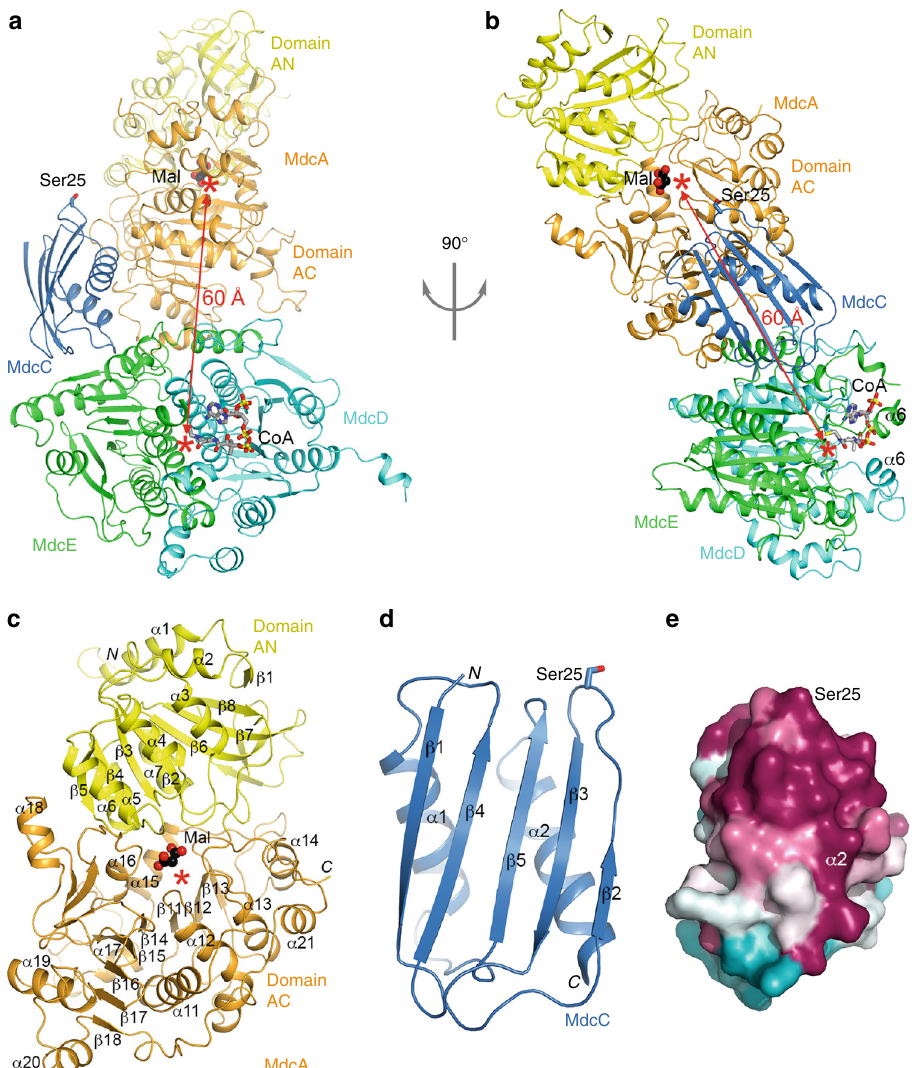
Figure 3 Structure of the MDC hetero-tetramer. a Schematic drawing of the structure of the MDC hetero-tetramer. The two domains of MdcA, AN and AC, are shown in yellow and orange , respectively. MdcC is shown in light blue , MdcD in cyan , and MdcE in green . The side chain of Ser25 in MdcC, the site of attachment of the prosthetic group, is shown as a stick model. A malonate bound in the active site of MdcA is shown as a sphere model ( black ) and labeled Mal. The bound position of CoA is also indicated ( gray ). The two active sites are indicated with the red asterisks , and the direct distance between them indicated with the red arrow . b Structure of the MDC hetero-tetramer, after 90° rotation around the vertical axis from a . c Structure of MdcA. d Structure of MdcC. e Molecular surface of MdcC colored based on sequence conservation 50 . Purple : highly conserved, cyan: poorly conserved. The view is related to that of d after a 90° rotation around the vertical